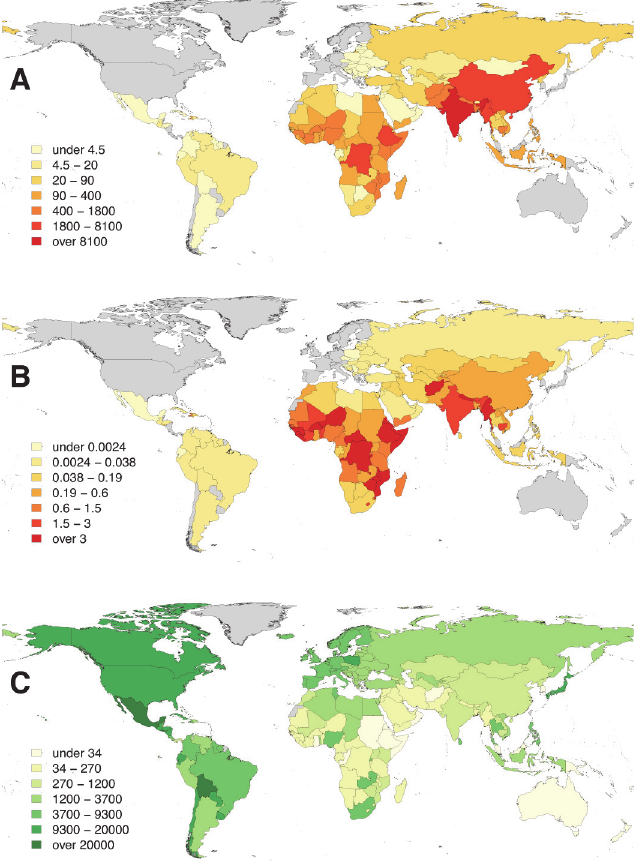
Fig 3. The distribution of the global burden of rabies: A) human rabies deaths, B) per capita death rates (per 100,000 persons), and C) expenditure on dog vaccination (per 100,000 persons). Countries shaded in grey are free from canine rabies.